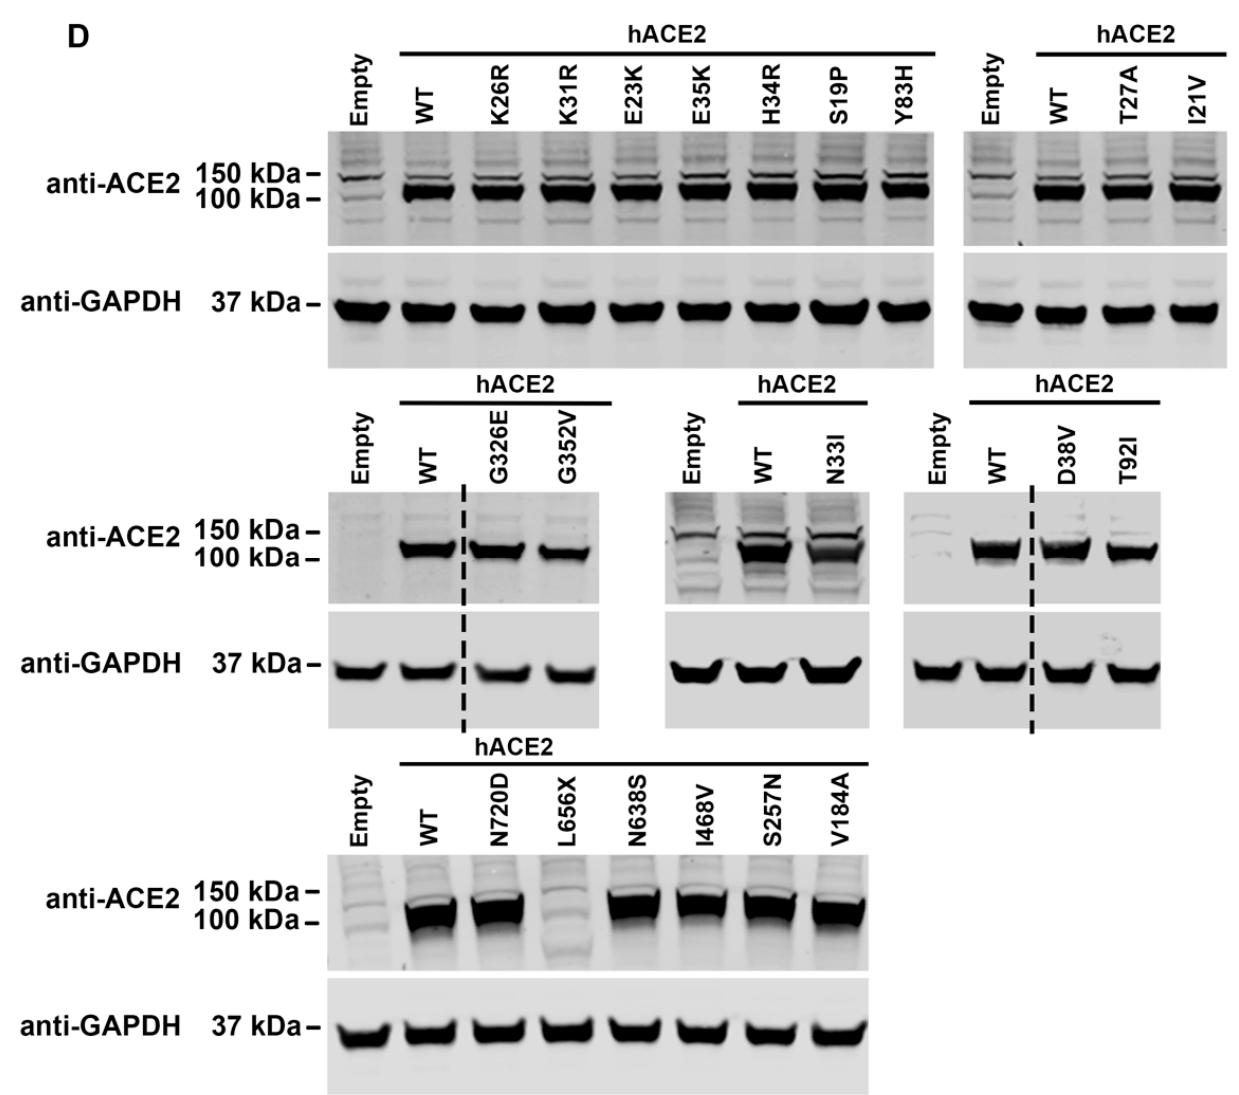
Figure 2. The effect of hACE2 polymorphisms on SARS-CoV-2 infection of cells. ( A – C ) Human HEK293 cells stably expressing the different hACE2 variants were infected with increasing volumes of a chimeric vesicular stomatitis virus expressing the SARS-CoV-2 wuhan spike-containing GFP as a reporter of infection (CoV-2 rVSV-GFP ). Empty vector pScalps-Puro served as a negative control (Empty). The infection was determined by measuring the percentage of GFP-positive cells 20 h post-challenge. Experiments were performed at least five times, and a representative infection is shown. Statistical analysis was performed using an intermediate value taken from the infection curves (bottom panels). Fold changes for infection with each variant with standard deviations are shown for at least five experiments. ** indicates p -value < 0.001, **** indicates p -value < 0.0001, NS indicates not significant as determined by using the unpaired t -test. ( D ) Expression of hACE2 in HEK293 cells stably expressing the different hACE2 variants was measured by Western blot analysis using anti-hACE2 antibodies. GAPDH was used as a loading control.